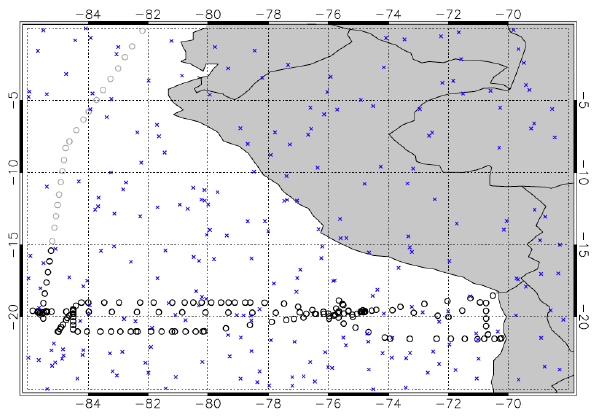
Fig. 1. Map of the ship-borne radiosonde (circle) and COSMIC RO Figure 1. Map of the ship-borne radiosonde (circle) and COSMIC RO sounding locations 3 (cross) sounding locations during VOCALS-REx field campaign (cross) during VOCALS-REx field campaign from October 20 to December 1, 2008. 4 from 20 October to 1 December